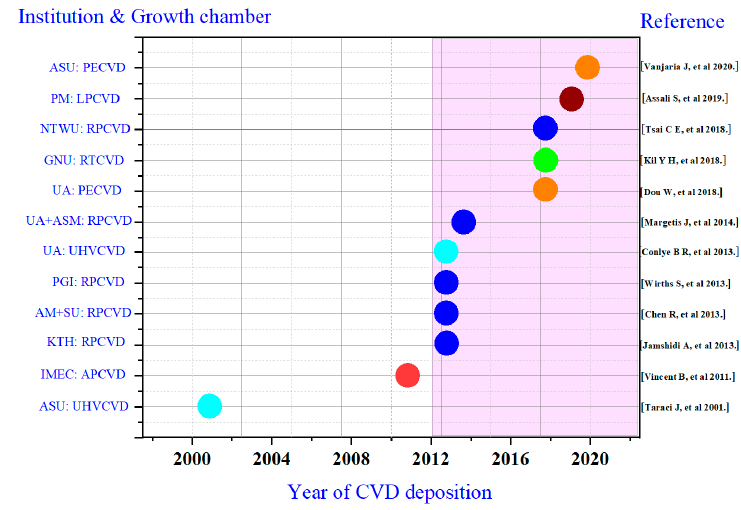
Figure 6. List of GeSn CVD growth papers by different groups.